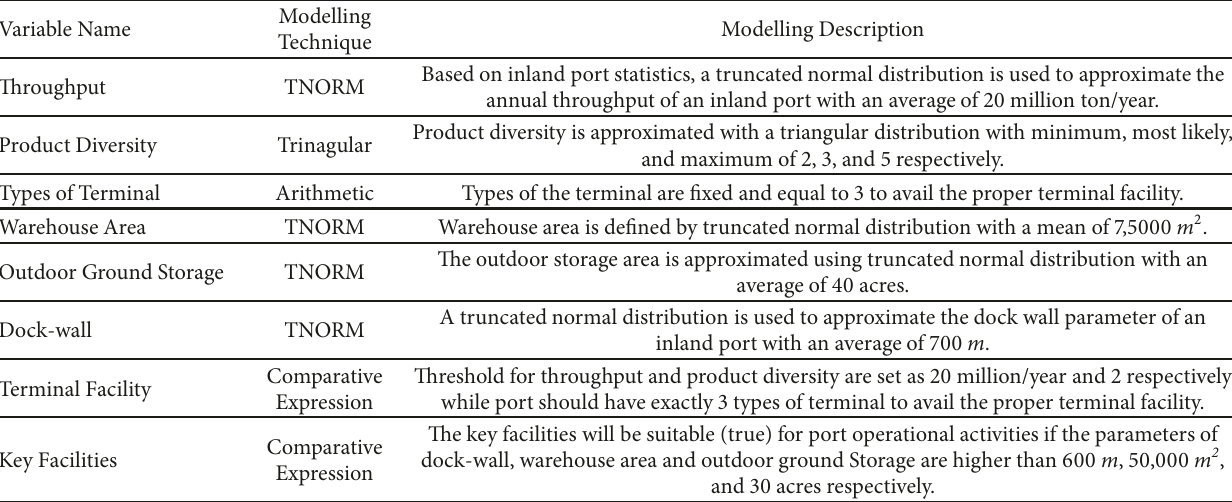
Table 3: Modelling of variables contributed to port facility.